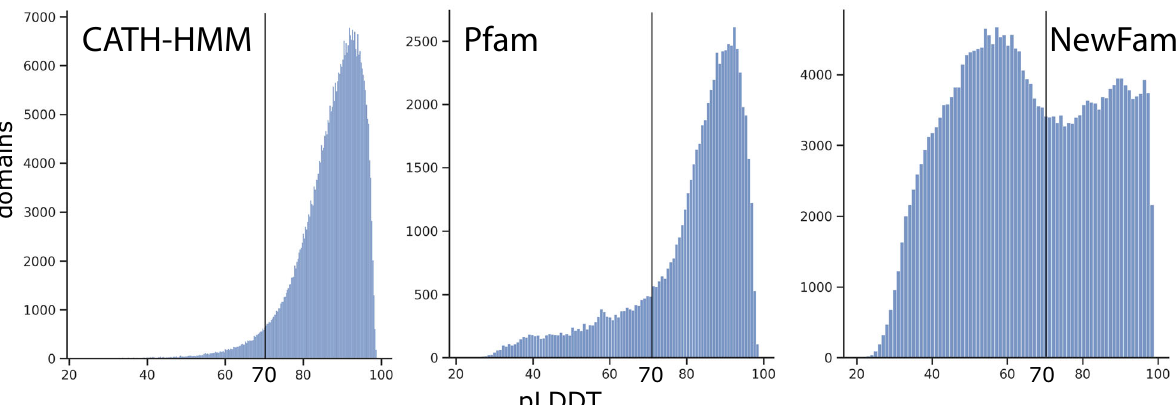
Fig. 2 Average model quality. The plots show the distribution of average pLDDT scores for domains divided by source. The pLDDT threshold for con fi dent model quality is highlighted ( ≥